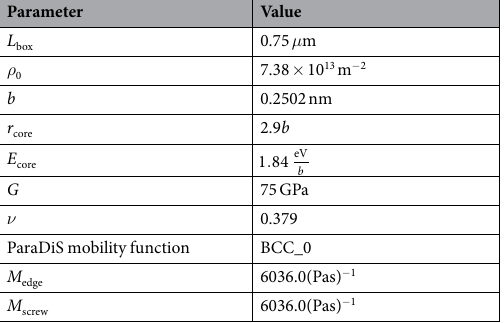
Table 1. Simulation parameters.